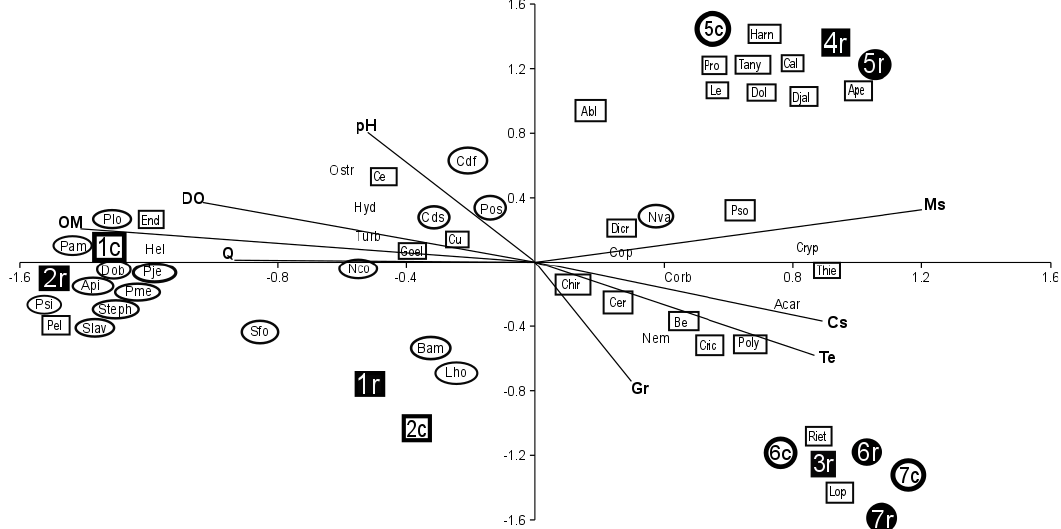
Figure 4. Triplot of Canonical Correspondence Analysis representing associations between macroinvertebrate densities and environmental variables. Square represent upstream sites, fill square: right bank sites, empty square: center sites. Circles represent downstream sites, fill circles: right bank sites, empty circles: center sites. Sites do not appear reported 0 organism. OM: organic matter; Q: discharge; DO: dissolved oxygen; Gr: gravel; Cs: coarse sand; Ms: medium sands; Te: temperature. Inside elypsis: Oligochaeta taxa and inside rectangles: Insecta taxa. Taxa acronyms in Table